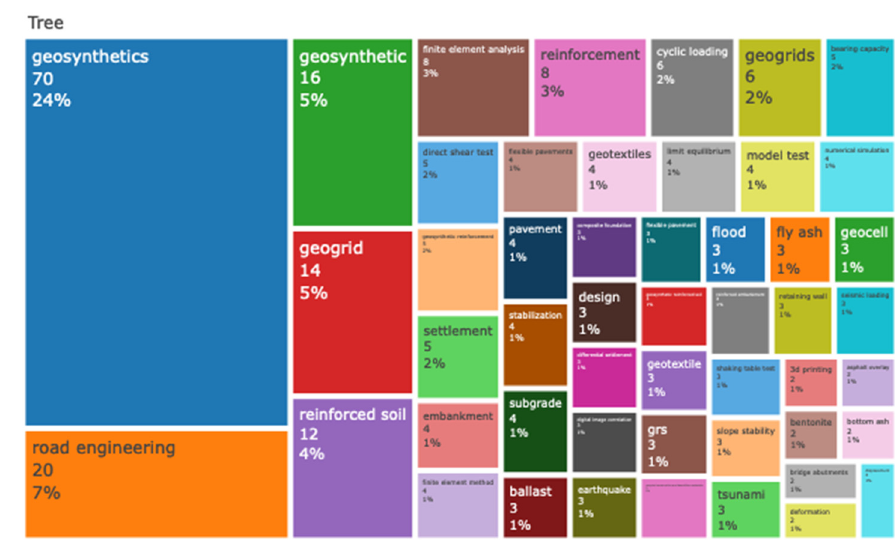
Figure 24. Thematic map.